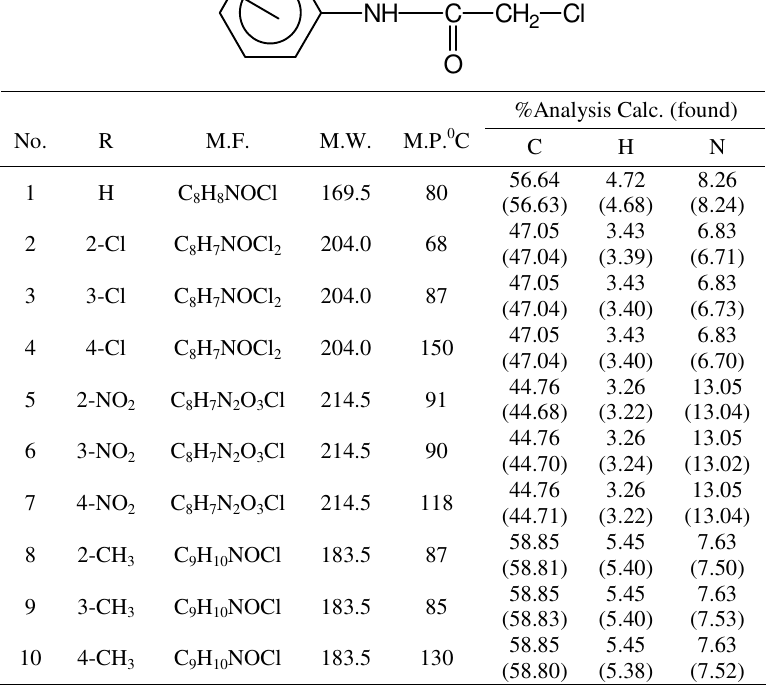
Table 1 . Physical and analytical data of n-chloroacetyl aryl amines